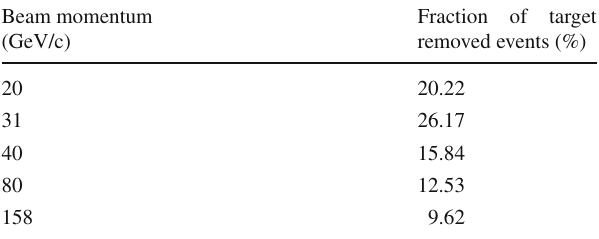
Fraction of target removed events (%)